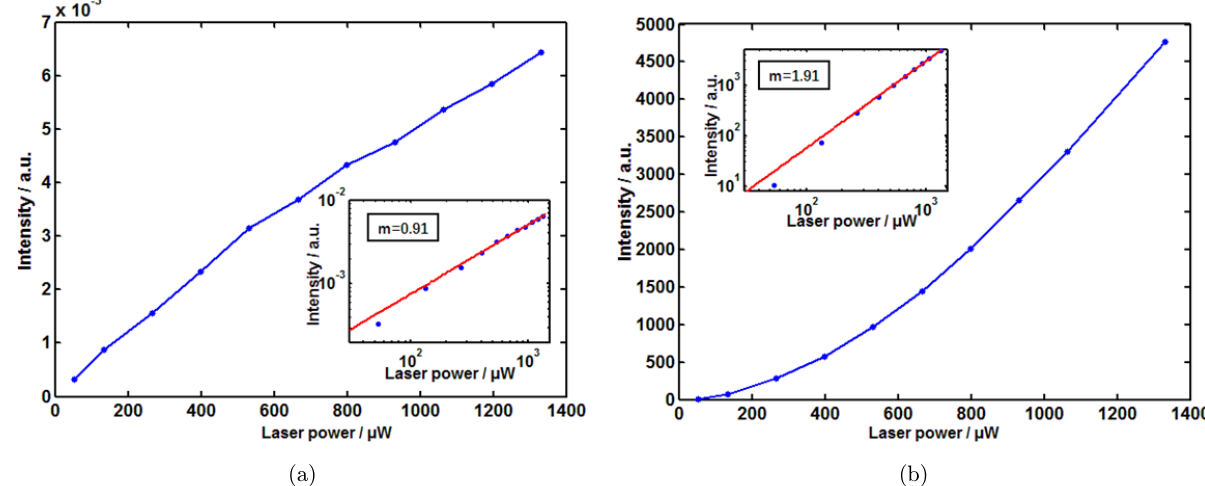
Fig. 3. Dependence of the luminescent intensity on excitation laser power for a single UCNP (a) and densely packed sample (b). Insets show the corresponding log – log plot.